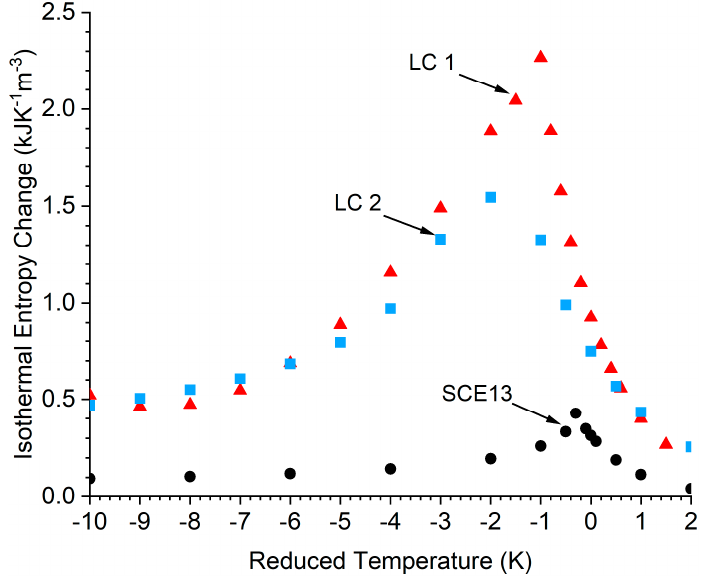
Figure 4. Isothermal entropy change per unit volume as a function of reduced temperature deter- mined using Equation (1). The results for SCE13 and LC 1 are for an effective field of 16 V µm − 1 , and an effective field of 14 V µm − 1 for LC 2. The peak position of SCE13 (black circles) is ~ − 0.3 K; for LC 1 (red triangles), the peak position is ~ − 1 K; for LC 2 (blue squares), the peak position is ~ − 2 K.